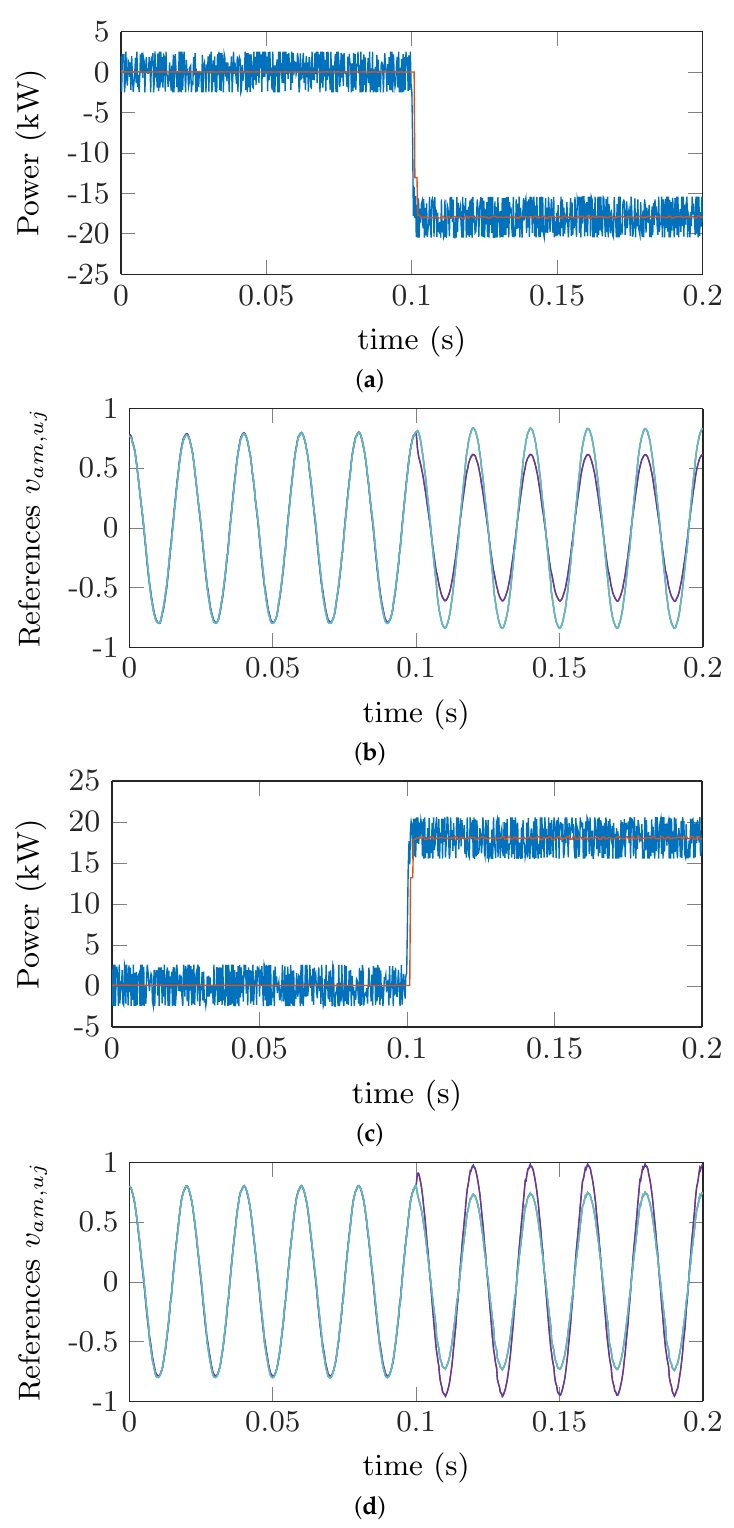
Figure 11. ( a ) Power flow during ESS charging; ( b ) reference signals; ( c ) power flow during ESS discharging; ( d ) reference